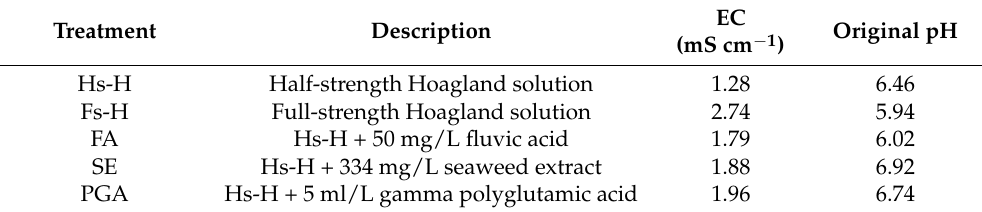
Table 2. Description, electrical conductivity (EC), and original pH of nutrient solution